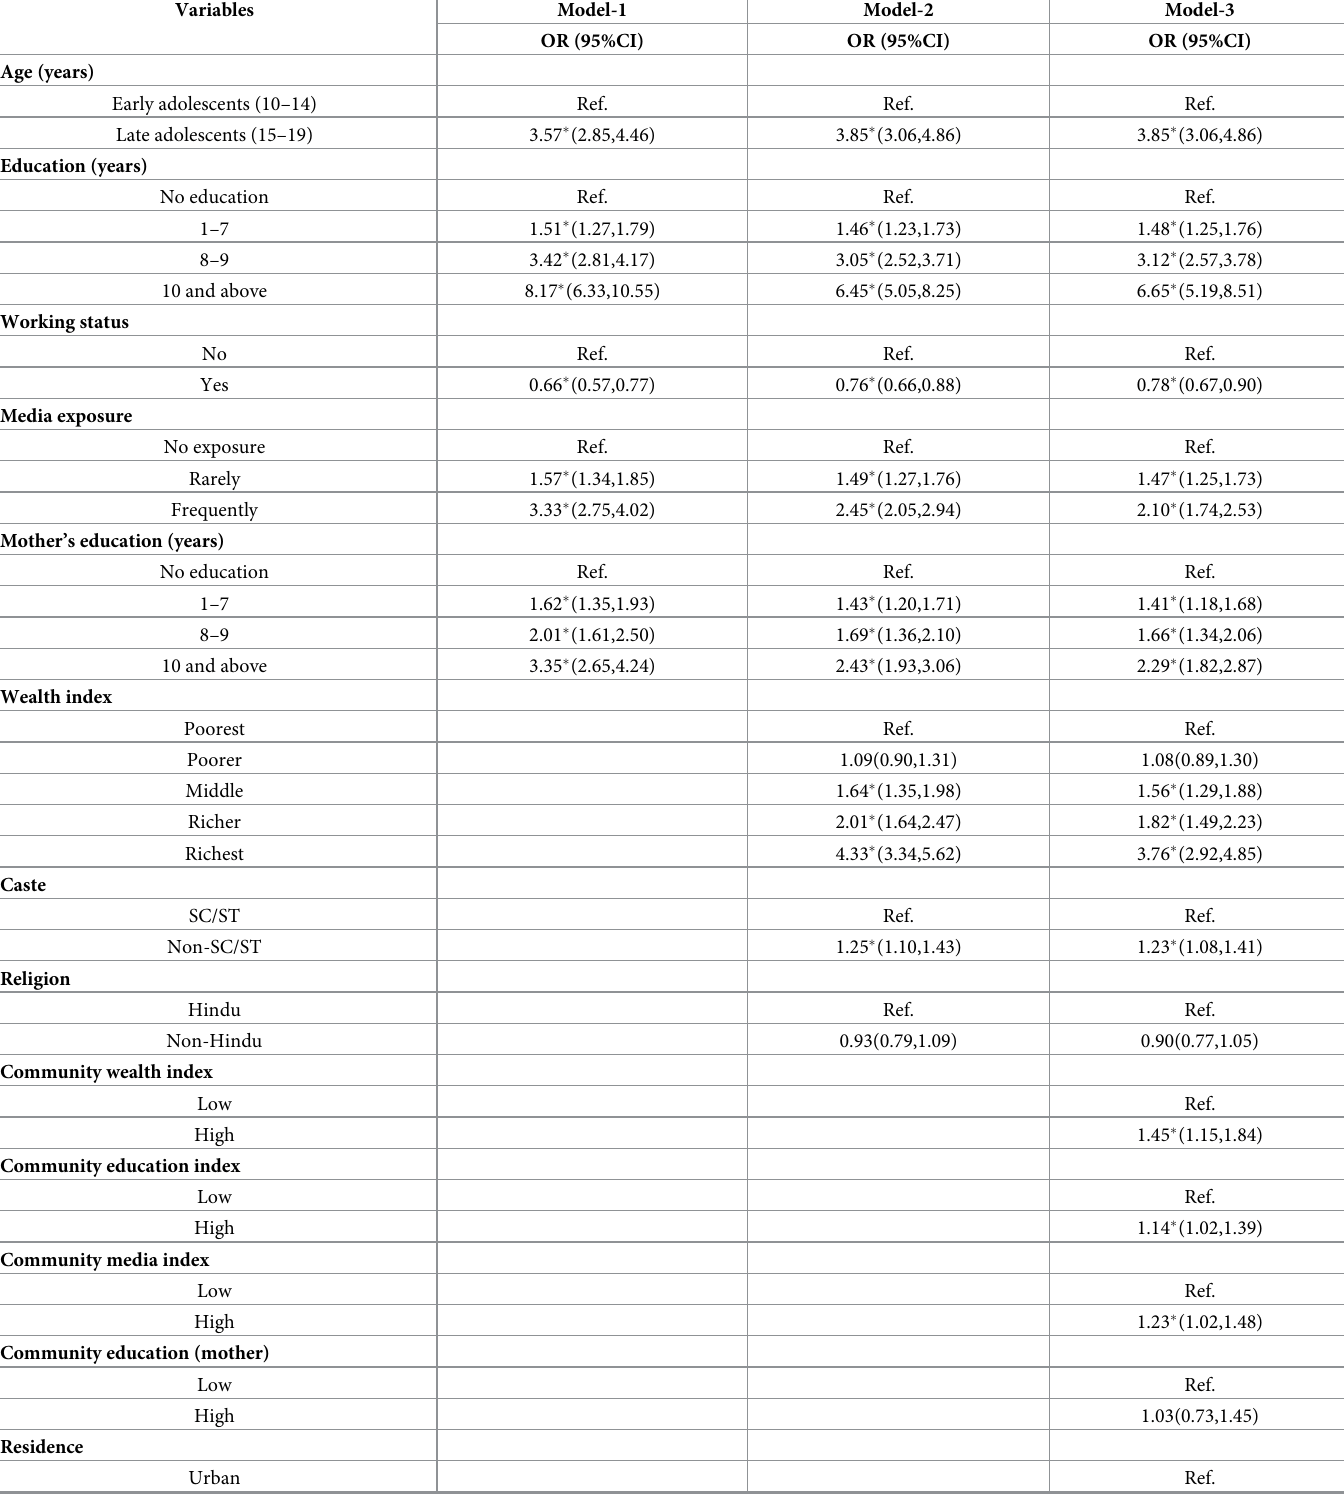
Table 3. Multilevel logistic regression analysis assessing the effect of background characteristics on the likelihood of use of sanitary napkins among